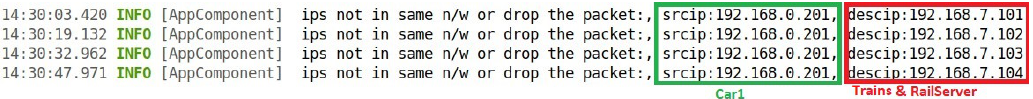
Figure 21. Flow entries for switch S22: VLAN ID assignment to train’s data packet.